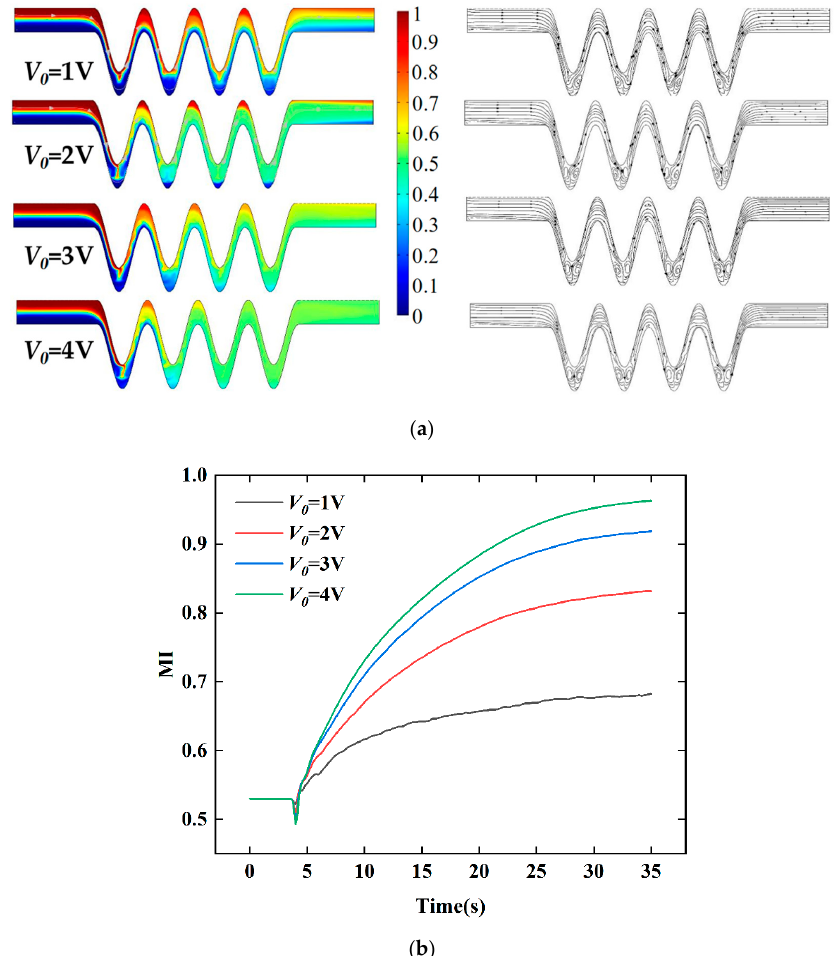
Figure 14. The effect of the voltage: ( a ) distributions of concentration surface along the micromixer for four values of voltage, ( b ) the mixing index at the outlet for different voltages within 0–35 s with four pairs of electrodes, and a phase shift of pi/4, U 0 = 0.1 mm/s, V 0 = 2 V, and f = 5